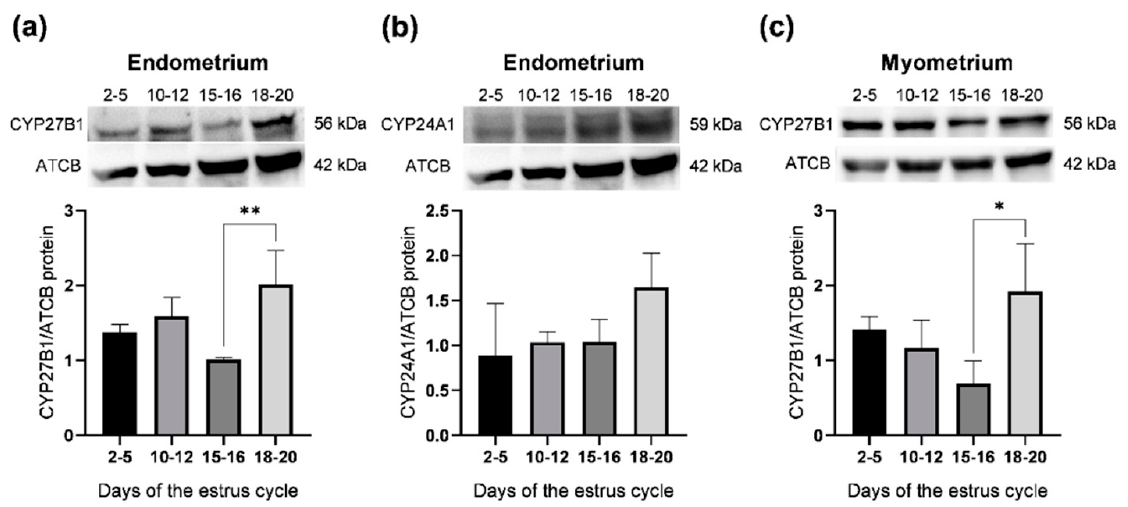
Figure 3. Relative protein abundance of CYP27B1 and CYP24A1 in the endometrium ( a , b , respectively) and CYP27B1 in the myometrium ( c ) obtained from pigs on days 2–5, 10–12, 15–16 and 18–20 of the estrous cycle. The relative protein abundance was examined with densitometry and expressed as the ratio relative to β –actin (ACTB). Each value represents the mean ± SD. * p < 0.05; ** p < 0.01 (one–way ANOVA followed by Tukey post hoc test). n = 5 per each group.